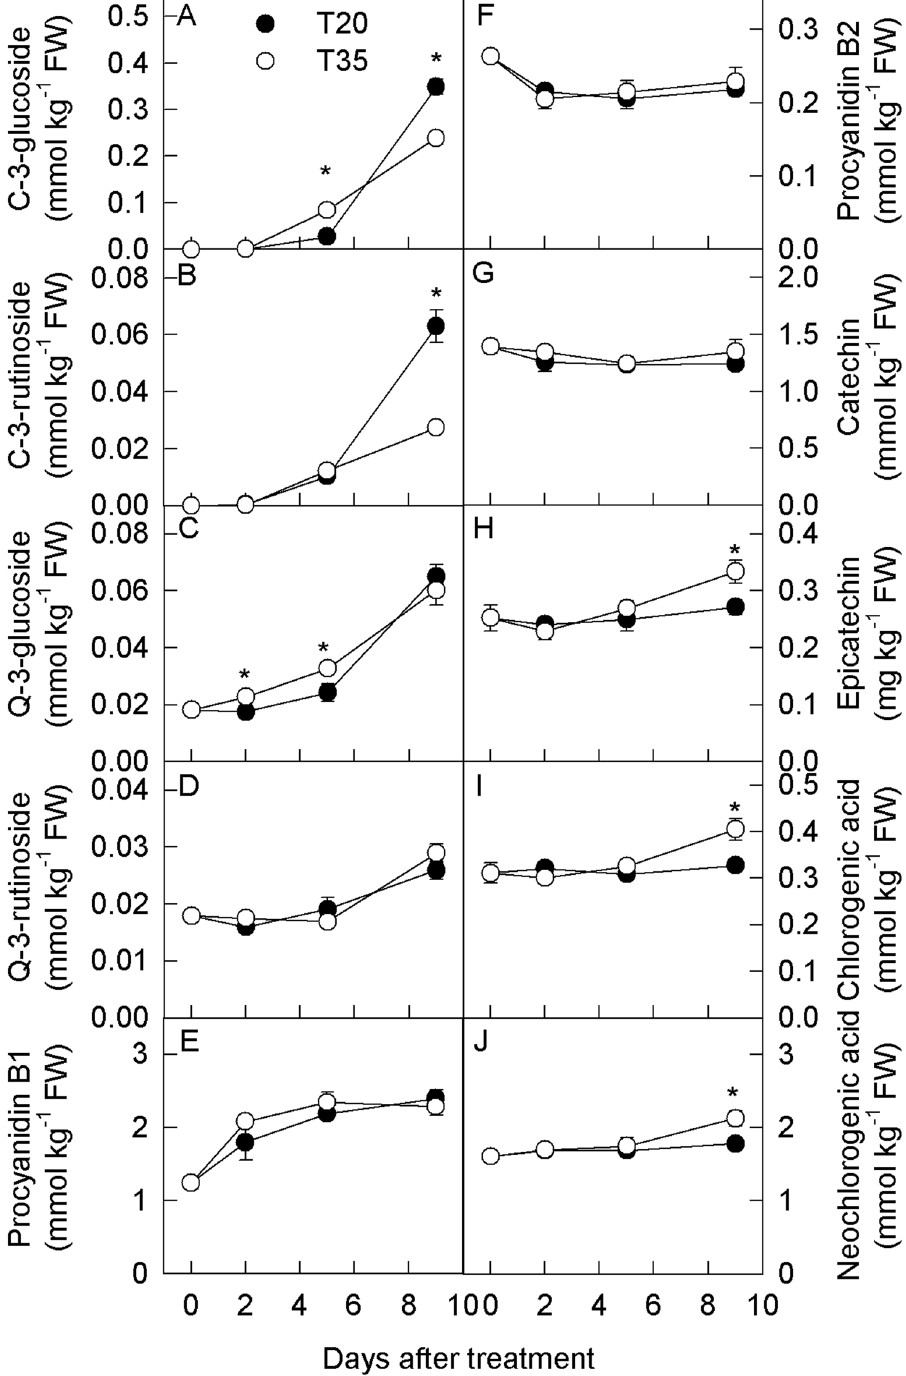
Figure 1. Concentrations of phenolic compounds in the peel of plum fruits treated at 20 °C and 35 °C for different time in the dark. Each data point represents mean ± SE (n = 5). The asterisk indicates a significant difference between two temperature treatments at P < 0.05, t -test. C-3-glucoside, cyanidin-3-glucoside; C-3-rutinoside, cyanidin-3-rutinoside; Q-3-glucoside,quercetin-3-glucoside; Q-3-rutinoside, quercetin-3- rutinoside. The same as